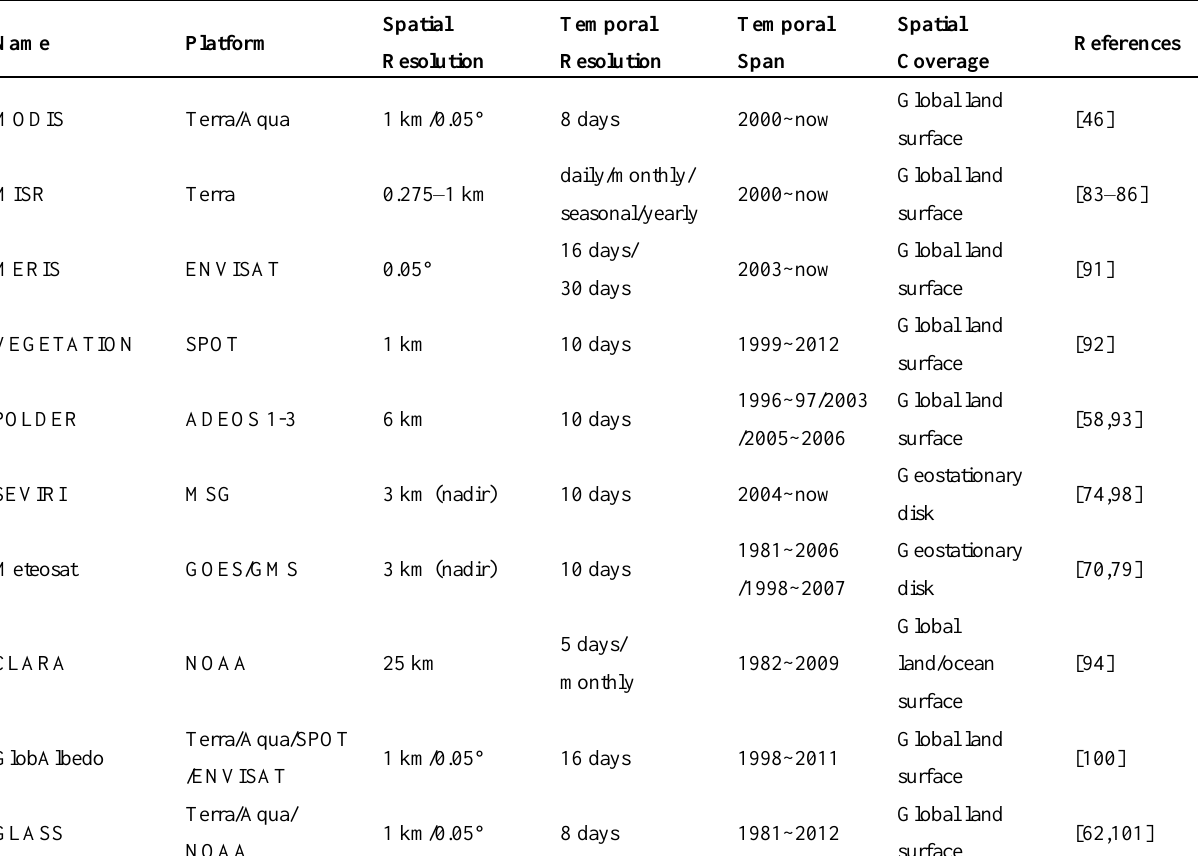
Table 1. List of current surface broadband albedo products derived from satellite